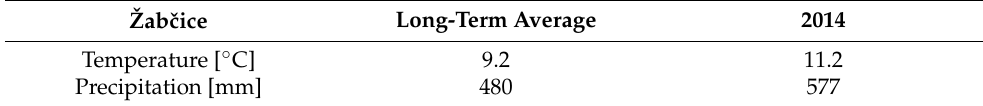
Table 2. Climatic characteristics of the experimental area in